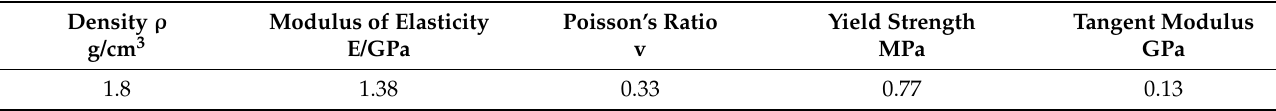
Table 3. Plugging material coefficient table.